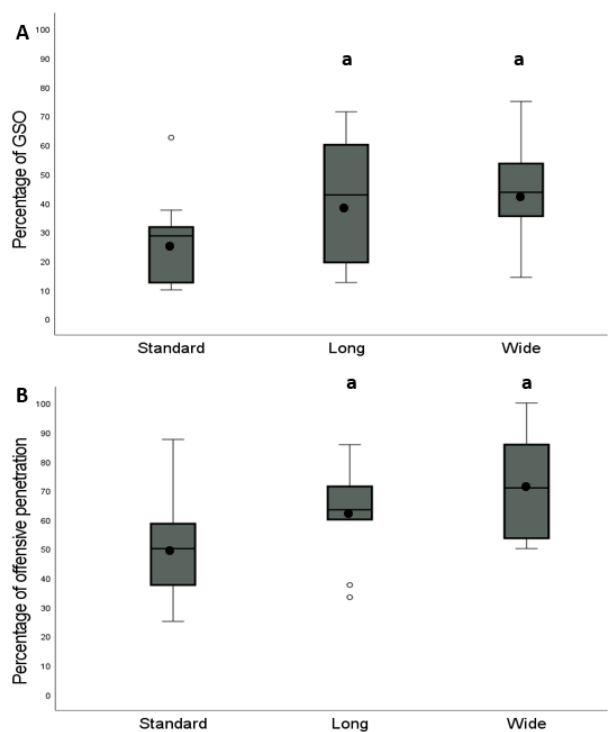
Figure 3. Box plot of the percentage of team possession that achieved ( A ) goal scoring opportunities and ( B ) offensive penetration during the different pitch configuration of the SSG. The box indicates the 25th and 75th quartiles and the central line is the median. The ends of the whiskers are the 2.5% and 97.5% values. Values outside the range of the whiskers are extreme values. Mean is represented with a black dot. a = significantly different ( p ˂ 0.05) from the “standard” configuration.